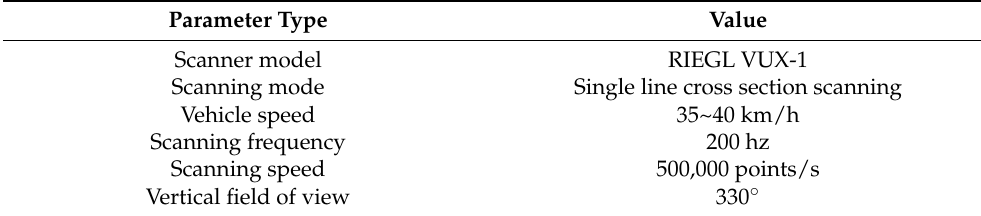
Table 1. Parameters of point clouds data collection.